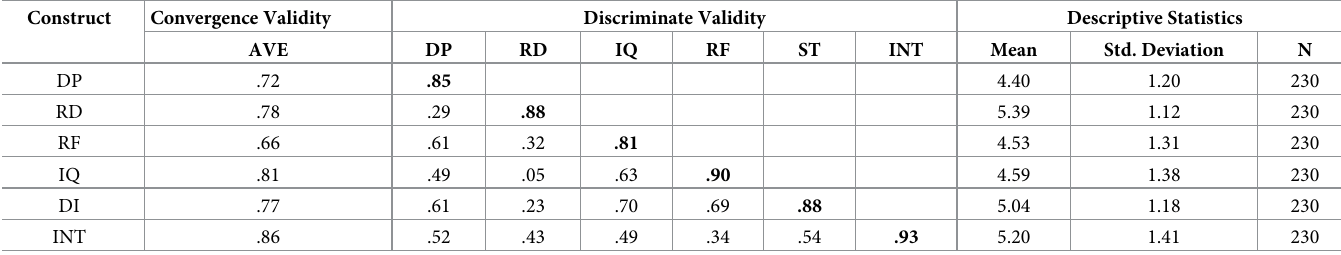
Table 4. Results of the validity